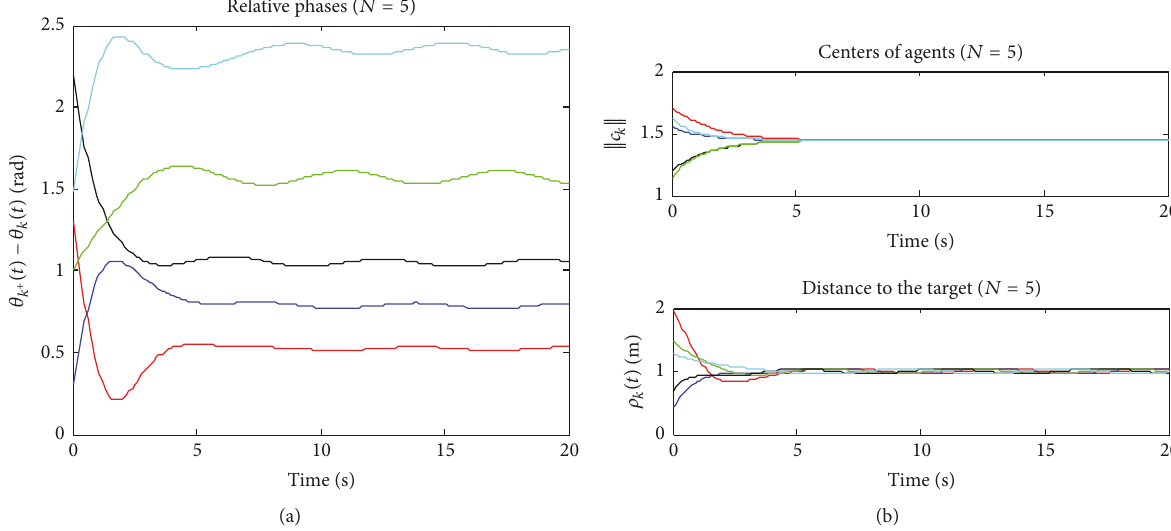
Figure 6: Trajectories with time of Figure 5. (a) Relative phases 𝜑 𝑘 + 𝑘 (𝑡) . (b) Consensus center and distances to it.